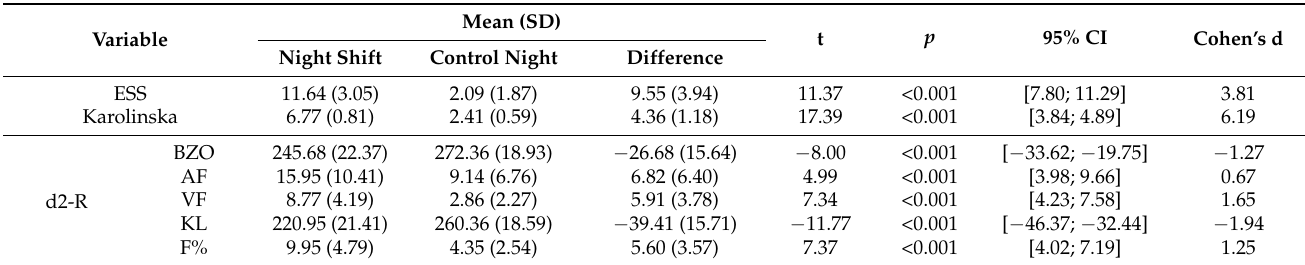
Table 5. Comparison of daytime sleepiness and concentration ability between the control night and the night shift. AF, “Auslassungsfehler“/omissions, BZO, “bearbeitete Zielobjekte”/number of completed objects; CI, confidence interval; ESS, Epworth Sleep Scale; F%, “Fehlerquote”/mistake rate; KL, “Konzentrationsleistung”/concentration, SD, standard deviation; VF, “Verwechslungsfehler”/mix-up mistakes.